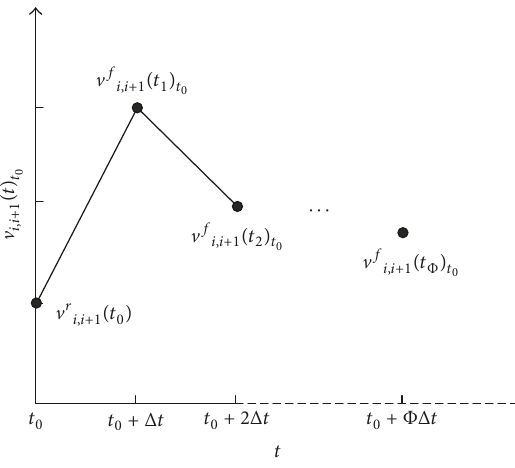
Figure 4: Travel speed function